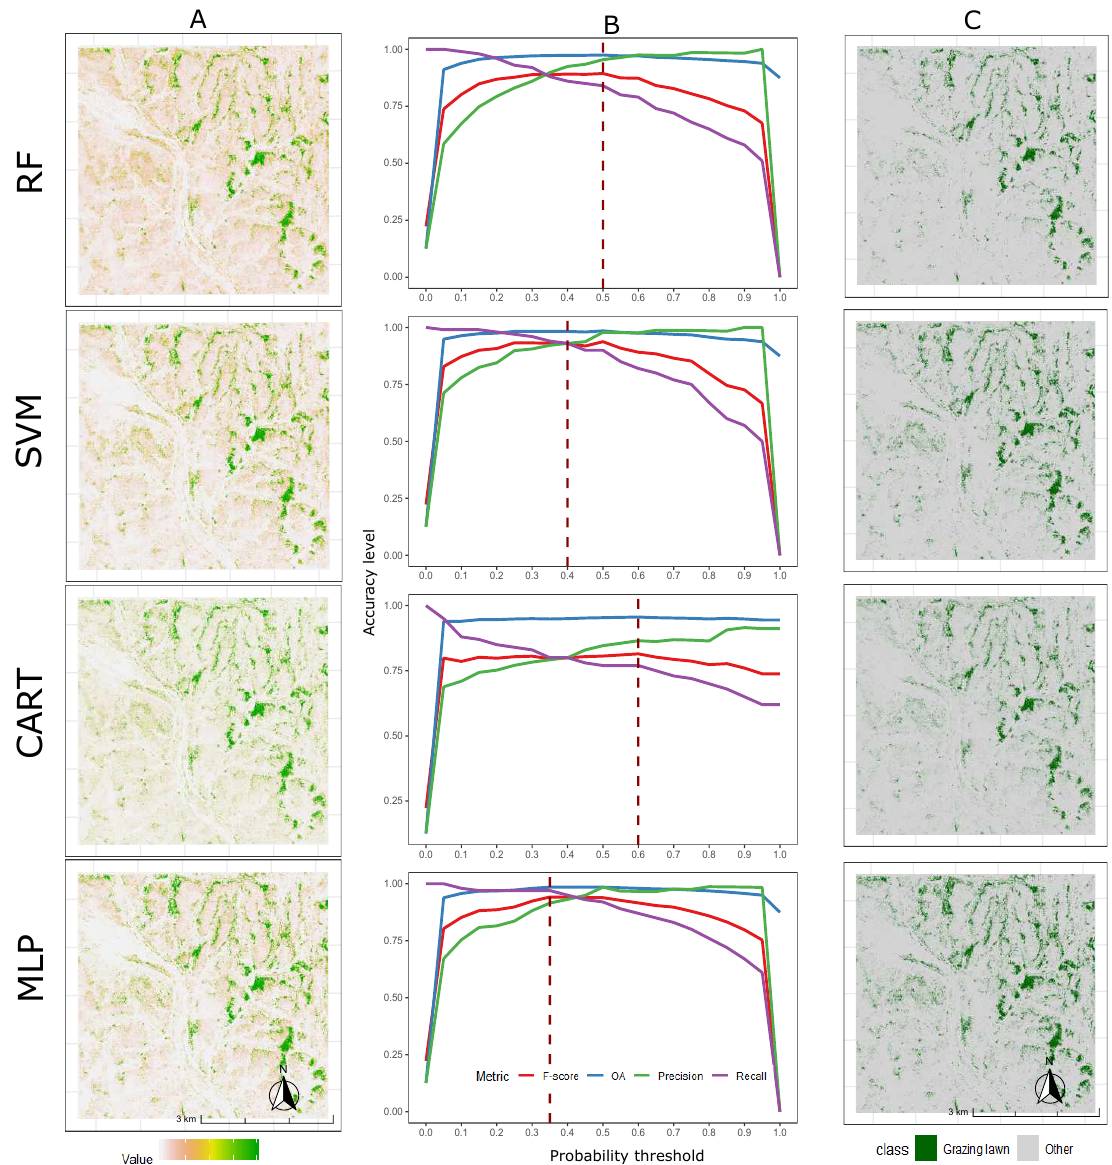
Figure 7. Grazing lawn occurrence probability surfaces ( A ); optimal probability threshold plot ( B ); and binary map of grazing lawn and other cover ( C ) derived from RF, SVM, CART and MLP models for the Lower Sabie